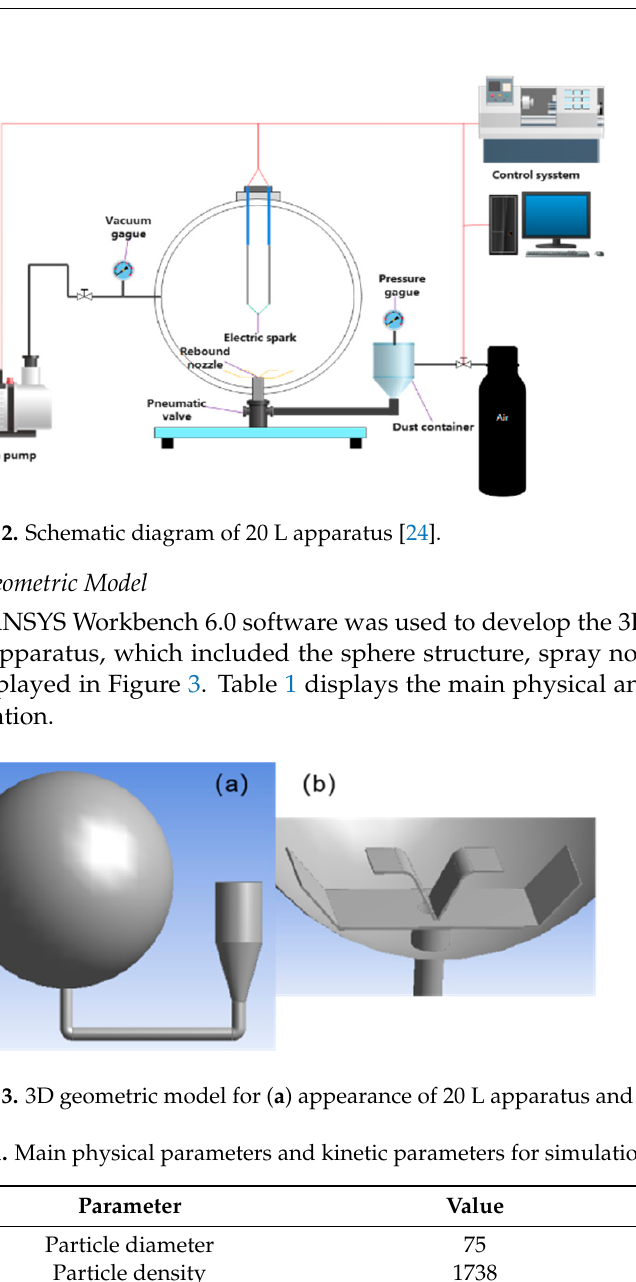
Figure 1. Particle size distribution of Mg.